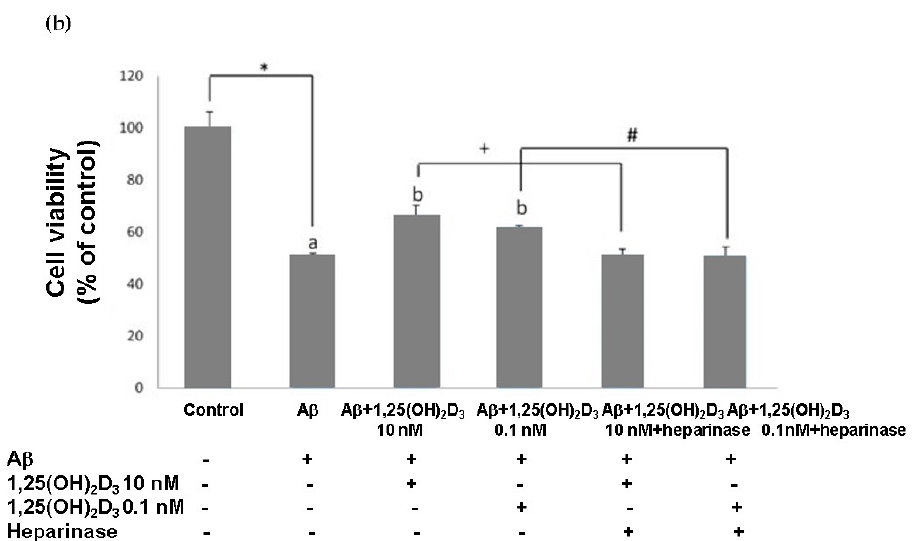
Figure 1. Effects of 1,25(OH) 2 D 3 on A β -induced changes in SH-SY5Y cell morphology and cell viability. ( a ) SH-SY5Y cell morphology. Bar, 10 μ M. Images were analyzed with SPOT 4.7 Advanced software. The arrows indicate the shorter neurite outgrowth of SH-SY5Y cells after the A β (25-35) challenge. ( b ) SH-SY5Y cell viability was analyzed by an MTT assay. SH-SY5Y cells were incubated with 1 µ M